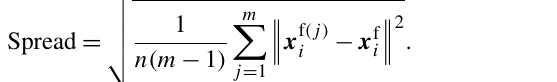
The elements of the matrix S o reflect the sensitivity of the where p i is the total number of observations at the i th time i normalized analysis state to the normalized observations; its diagonal elements are the analysis self-sensitivities and the off-diagonal elements are the cross-sensitivities. On the other hand, the elements of the matrix S f reflect the sensitivity of i the normalized analysis state to the normalized forecast state. The two quantities are complementary, and the GCV func- tion can be interpreted as minimizing the normalized fore- cast sensitivity because the inflation scheme will increase the observation weight appropriately.